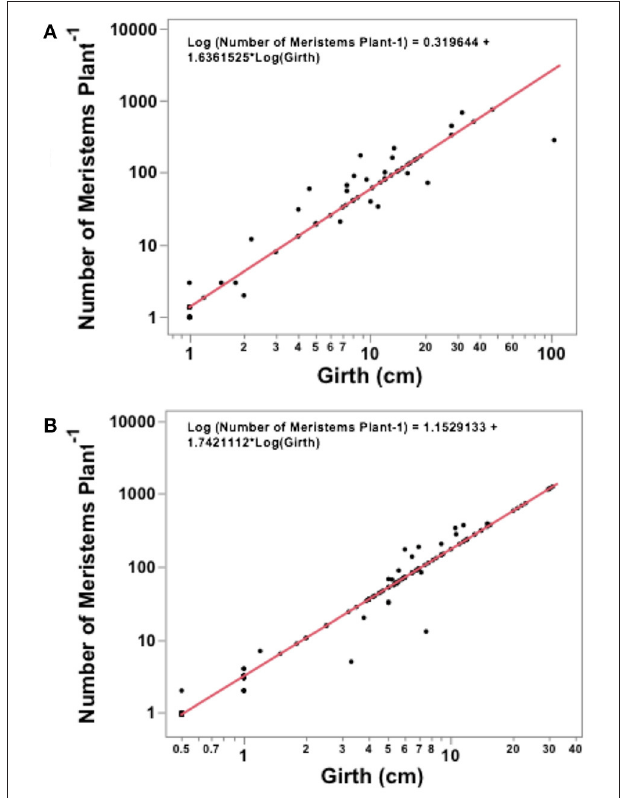
FIGURE 3 | Regression analysis for the Avicenna marina girth and total number of meristems produced in (A) Khor Alkharar and (B) Thuwal